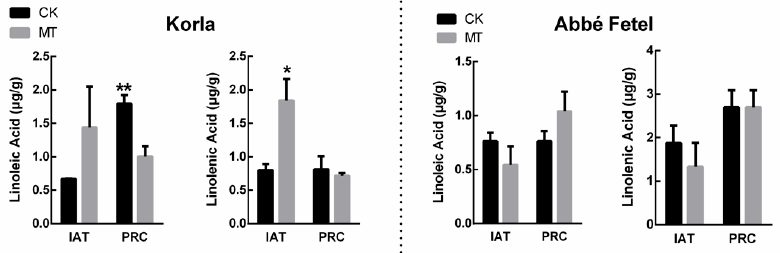
Figure 3. Effect of melatonin on linoleic acid and linolenic acid content. Data are means ±SE of three replicates. * p < 0.05, ** p < 0.01.